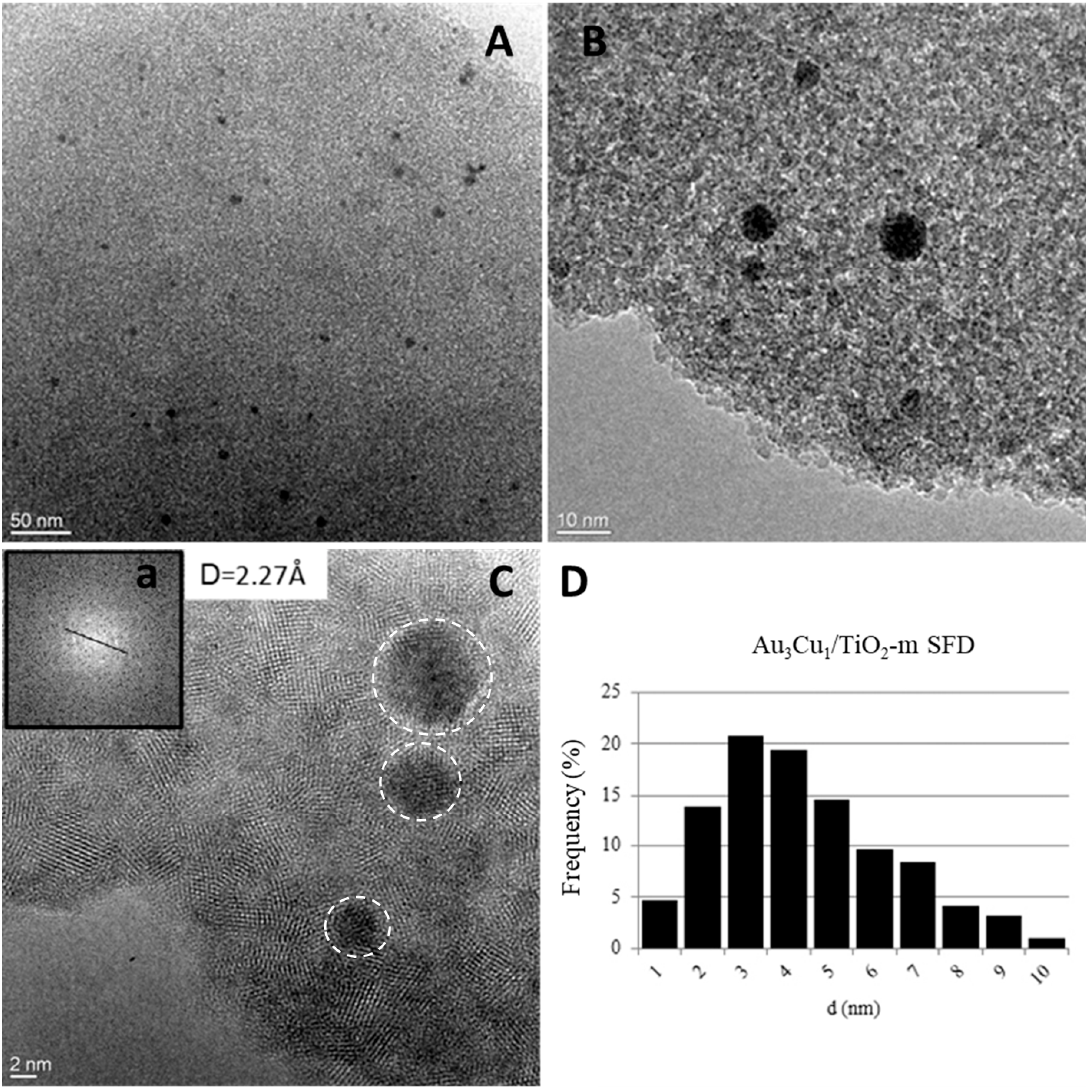
Figure 5. HR-TEM images ( A – C ) and histogram ( D ) of particle’s dimension of Au 3 Cu 1 nanoparticles deposited on TiO 2 -m SFD. The inset ( a ) in figure C shows the FFT of a representative nanoparticle (distance at 2.27 Å).